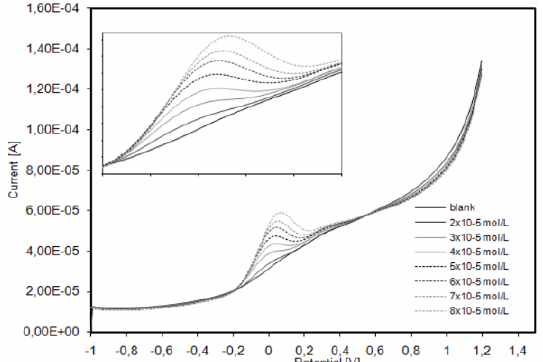
Figure 2. Square wave voltammograms of MTMIQ. The supporting electrolyte was 0.1 mol L -1 citrate buffer at pH 5. Other experimental conditions were: f = 130 Hz, E Δ E = -12 mV.